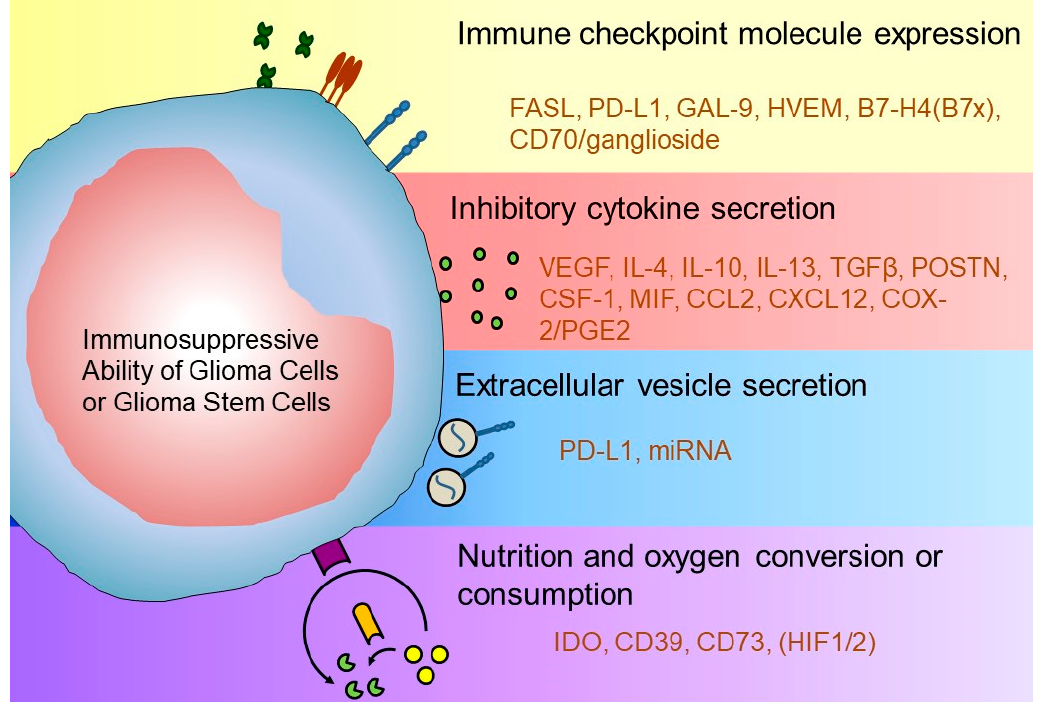
Figure 1. Glioblastoma cell immunosuppressive ability and cell-to-cell interactions in the glioma microenvironment. The immunosuppressive tumor microenvironment is created by altering the immune checkpoint molecule expression, immunosuppressive cytokine secretion, extracellular vesicle secretion, and oxygen nutrition status.